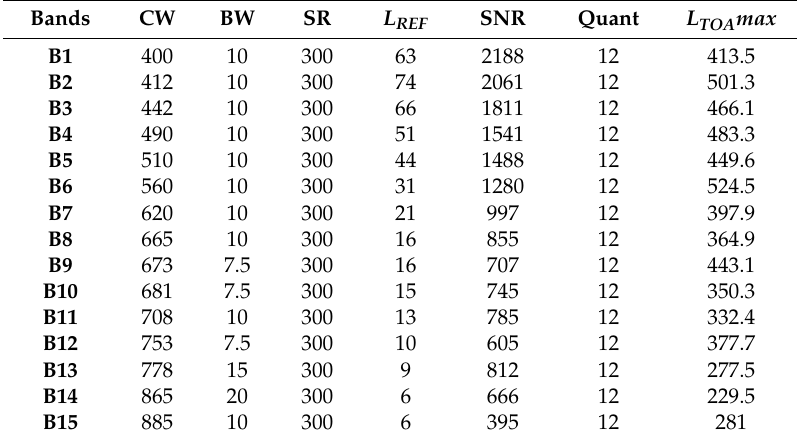
Table 3. OLCI/Sentinel-3 sensor configurations used as the input for simulation. CW is the central wavelength (nm), BW is the band width (nm), SR is the Spatial Resolution (m), L REF (W · m − 2 · sr − 1 · µ m − 1 ) is the radiance in which the SNR was calculated, Quant is the quantization,